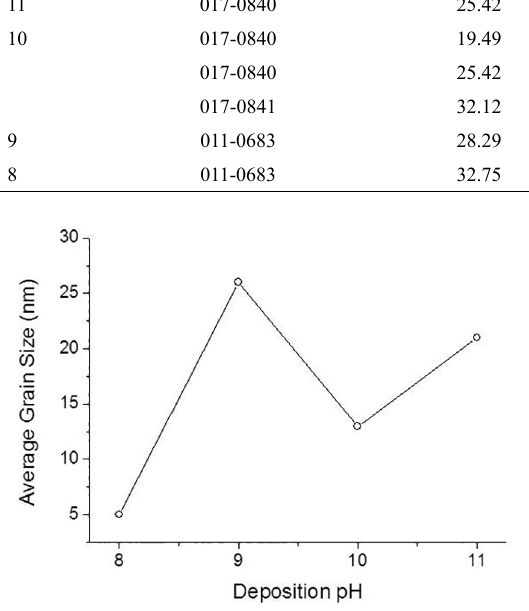
thin films were 4 films deposited at 4